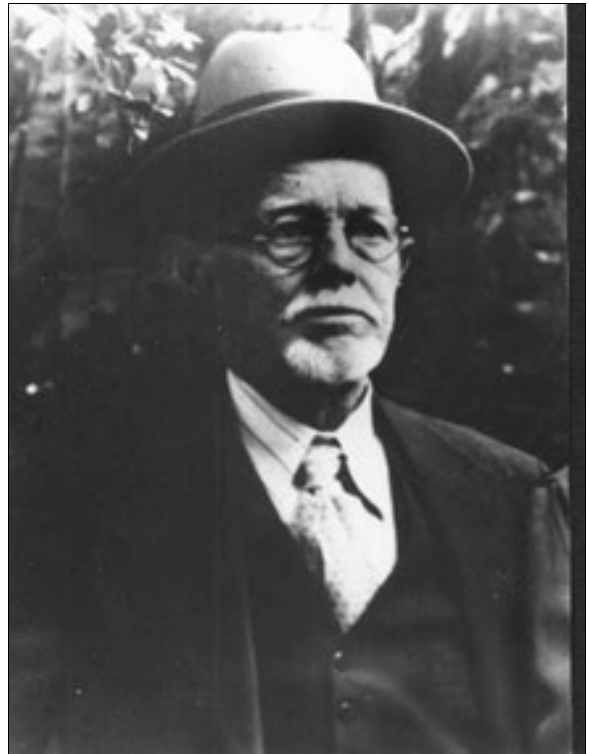
Figure 2: George William Onions (1866–1941), the hobbyist beekeeper who was among the first to make critical and detailed observations of reproductive parasitism by Apis mellifera capensis laying workers.